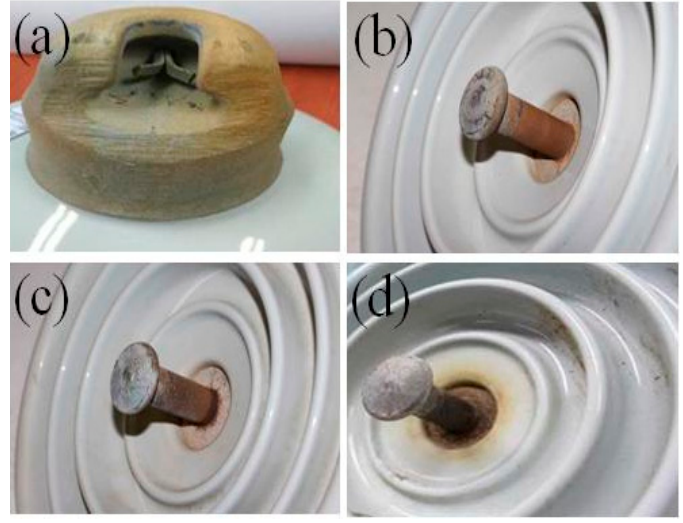
Figure1. ( a )Heavilyrustedmetalcap, ( b )Heavilyrustedpin, ( c )Damagedcementsurface, ( d )Damaged Figure 1. ( a ) Heavily rusted metal cap, ( b ) Heavily rusted pin, ( c ) Damaged cement surface, ( d ) porcelain Damaged porcelain body.